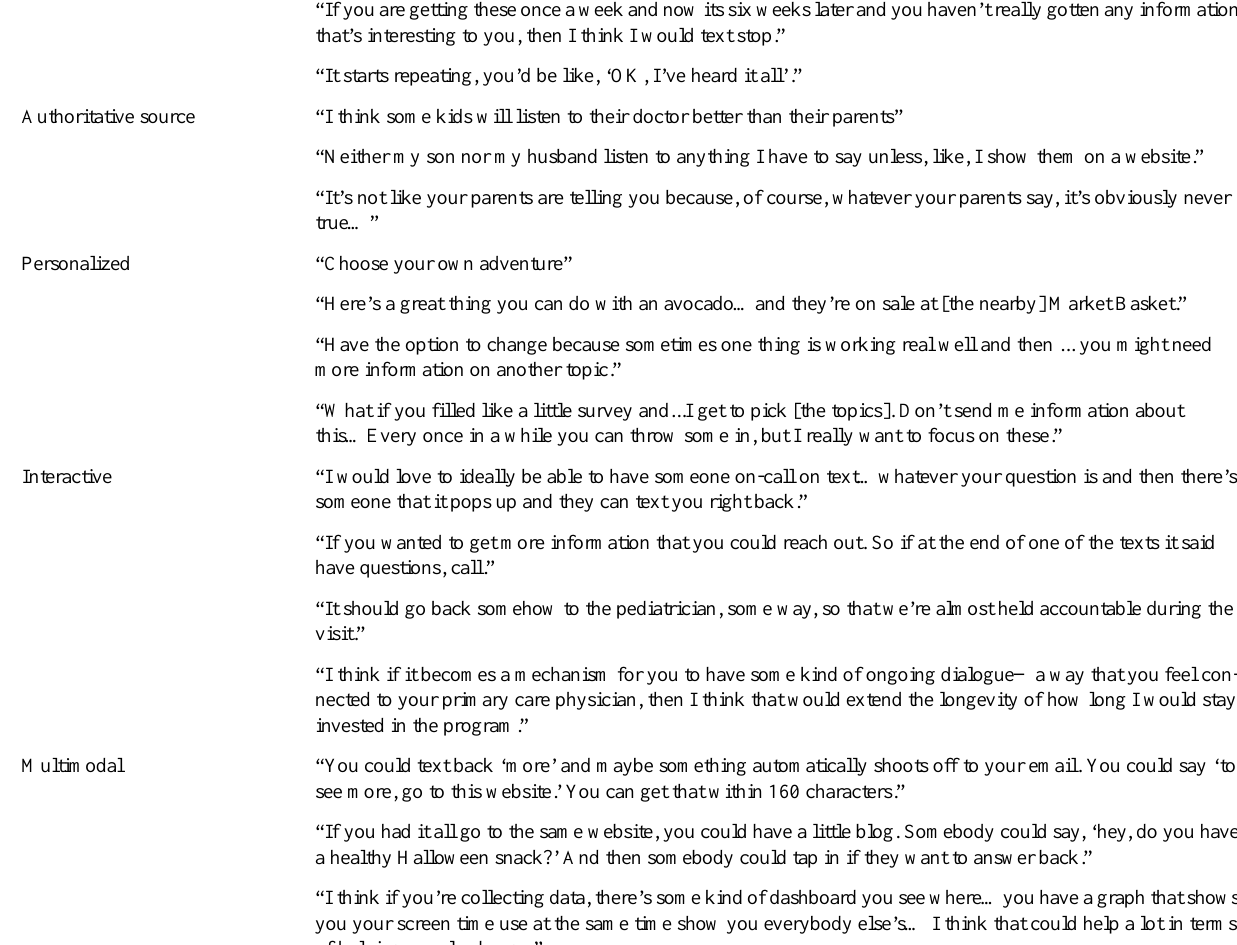
Representative quotationsTopic